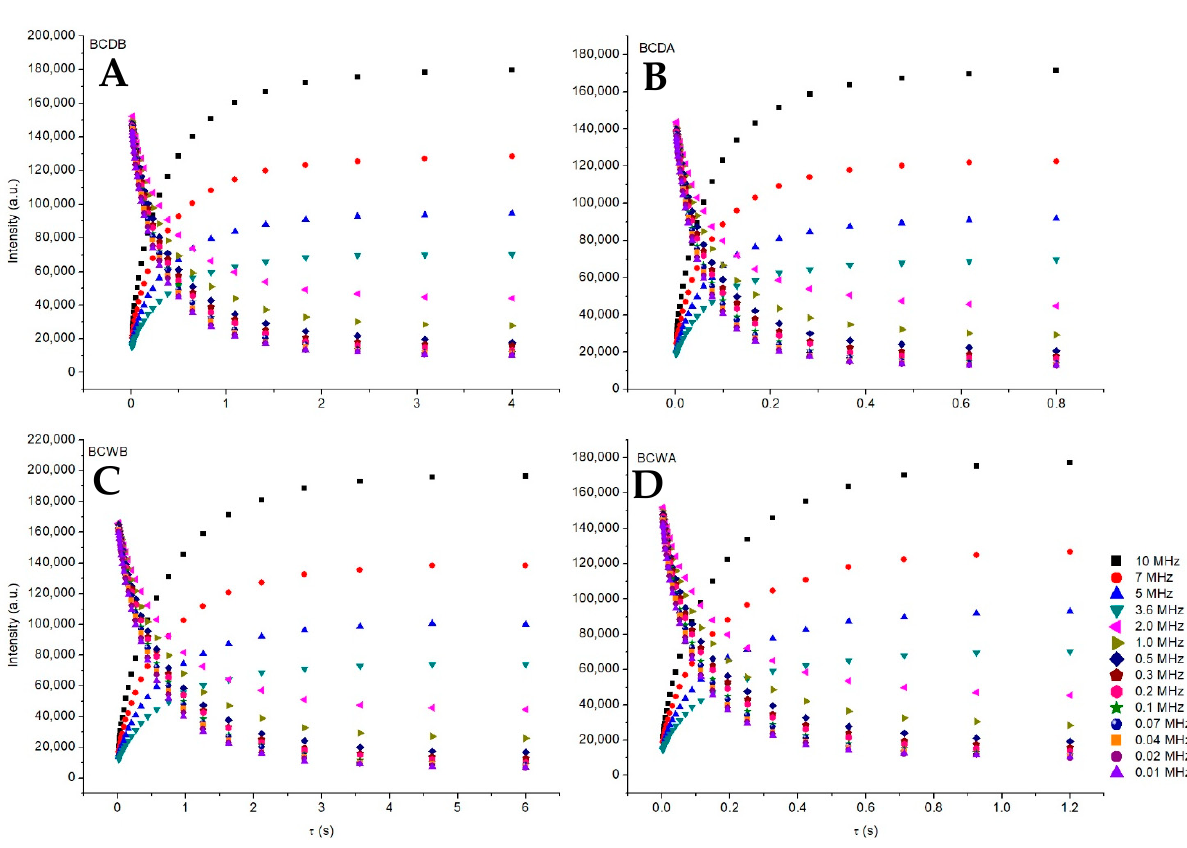
Figure A1. Decay and recovery curves obtained by applying the non-polarized and pre-polarized NMR sequence, respectively. ( A ) Experimental results from the analyses of the biochar obtained by the dry − quenched procedure before application to soil (BCDB). ( B ) Experimental results from the analyses of the biochar obtained by the dry − quenched procedure after application to soil (BCDA). ( C ) Experimental results from the analyses of the biochar obtained by the wet − quenched procedure before application to soil (BCWB). ( D ) Experimental results from the analyses of the biochar obtained by the wet − quenched procedure after application to soil (BCWA).